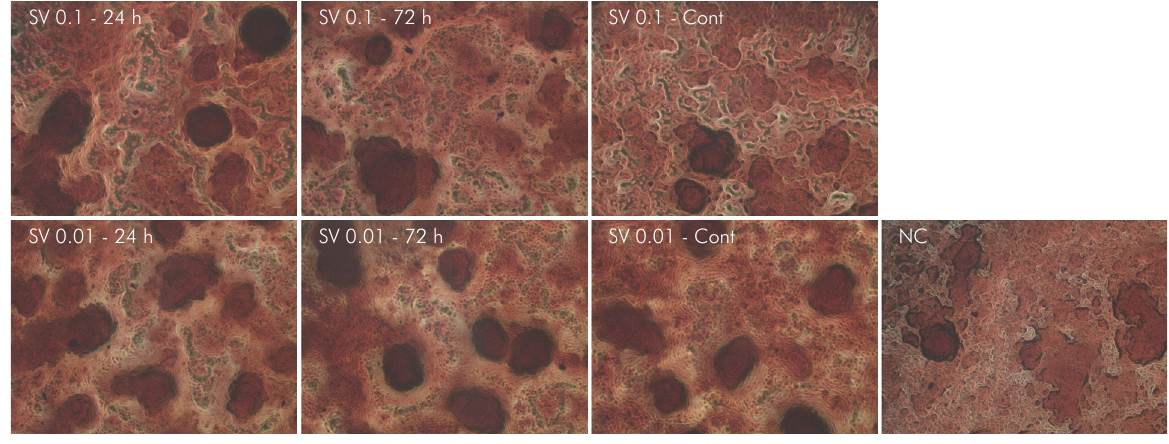
Figure 5. Representative images of the Alizarin Red assay for each group at 14 days (light microscopy, 4X). Note the increased nodule formation for all groups exposed to SV in comparison to NC, except for SV 0.1 in continuous mode, which shows features similar to